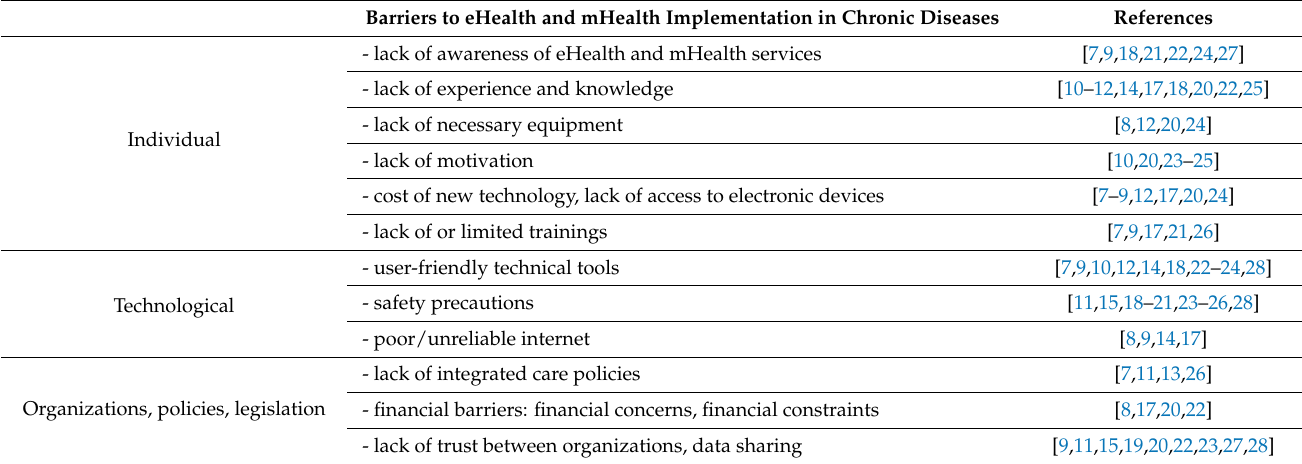
Table 1. Overview of the results—barriers.